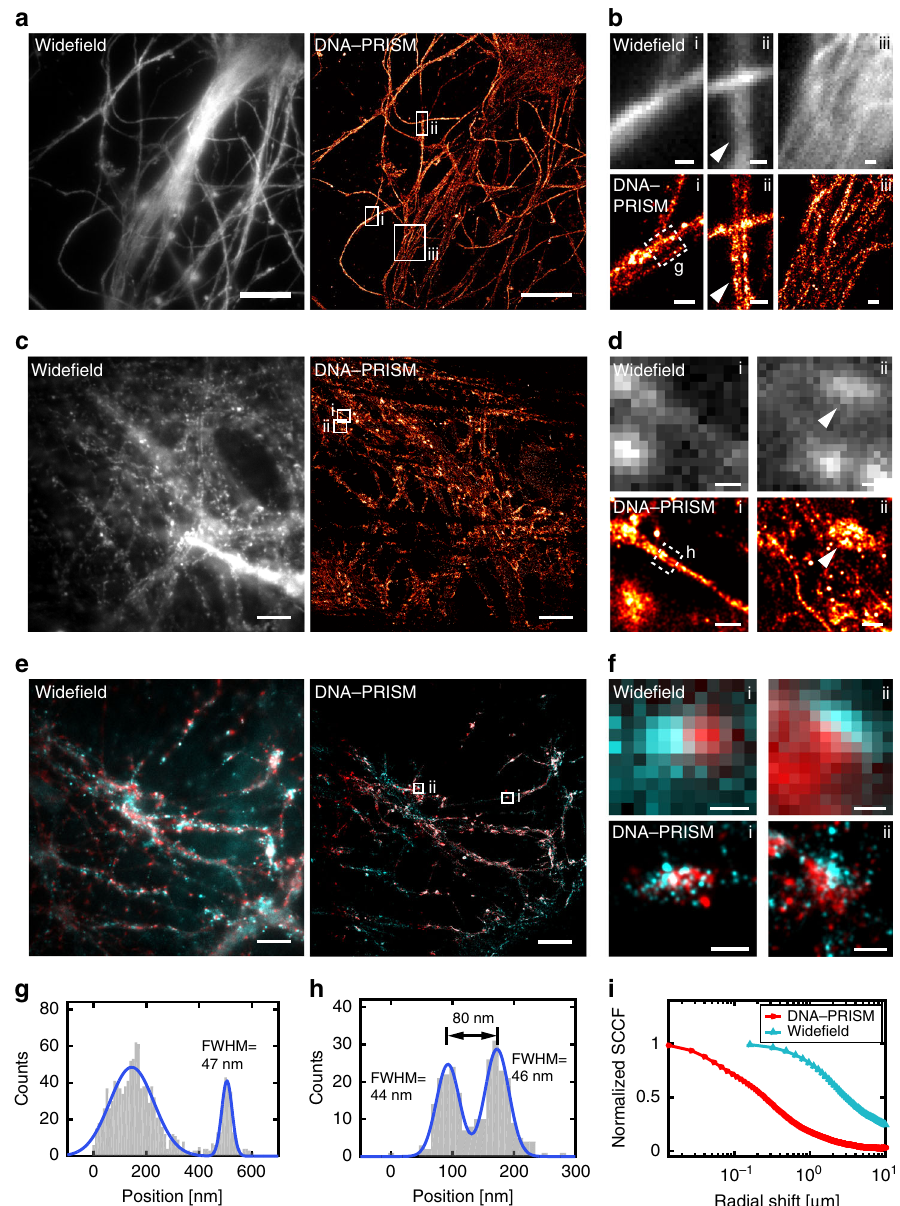
Fig. 6 Super-resolution DNA-PRISM imaging of primary neuronal cultures. a Wide fi eld and DNA-PRISM images of neuronal microtubules stained using the DNA-conjugated anti-Tuj-1 antibody. b Zoom-in view of the boxed areas in ( a ) show resolution enhancement of DNA-PRISM images compared with wide fi eld images. The arrowhead indicates distinct microtubule bundles that are not resolved in the wide fi eld image. c Wide fi eld and DNA-PRISM images of fi lamentous actin stained using DNA-conjugated phalloidin. d Zoom-in views of the boxed areas in c show two actin fi laments (left) and the synaptic actin punctae with sub-synaptic structures (right, arrowhead) that are not resolved in wide fi eld images. e Wide fi eld and DNA-PRISM images of pre- synaptic marker synapsin-I (red) and post-synaptic marker PSD-95 (cyan) of the same fi eld of view. f Zoom-in view of single synapses indicated by boxes in e . g Cross-sectional pro fi le of the boxed region in ( b ) shows a microtubule bundle next to a possible single microtubule with FWHM = 47 nm. h Cross- sectional pro fi le of the boxed region in d shows two actin fi laments or small fi lament bundles that are 80 nm apart. i The average size of synapses de fi ned by synapsin-I and PSD-95 is quanti fi ed using the normalized radial cross-correlation function. The decay at the smaller radial shift of the DNA-PRISM curve (red) indicates the smaller synapse size in the DNA-PRISM image due to the improved spatial resolution. Scale bar: a , c , e 10 μ m; b , d , f 0.5 μ